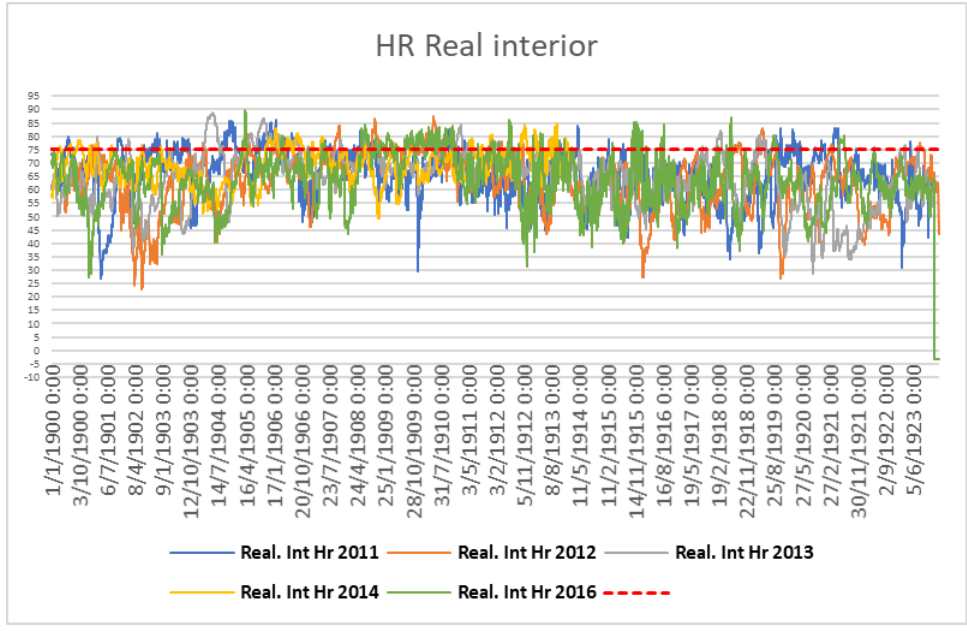
Figure 19. Hourly relative humidity.